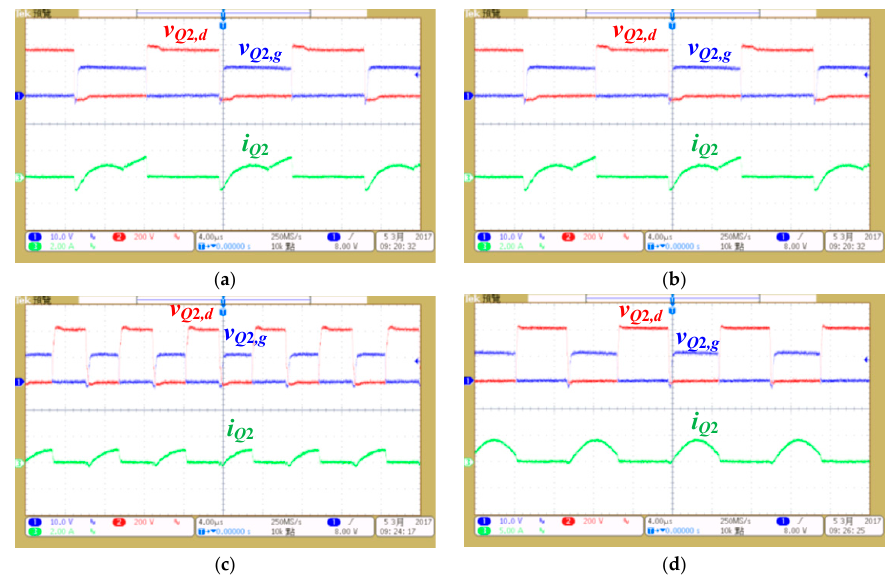
Figure 9. Test results of Q 1 under ( a ) V H = 350 V and 20% load [ v Q 1 ,g : 10 V/div; v Q 1 ,d : 200 V/div; i Q 1 : 2 A/div; time: 4 µs/div] ( b ) V H = 350 V and 100% load [ v Q1,g : 10 V/div; v Q 1 ,d : 200 V/div; i Q 1 : 5 A/div; time: 4 µs/div] ( c ) V H = 400 V and 20% load [ v Q 1 ,g : 10 V/div; v Q1,d : 200 V/div; i Q 1 : 2 A/div; time: 4 µs/div] ( d ) V H = 400 V and 100% load [ v Q 1 ,g : 10 V/div; v Q 1 ,d : 200 V/div; i Q 1 : 5 A/div; time: 4 µs/div].